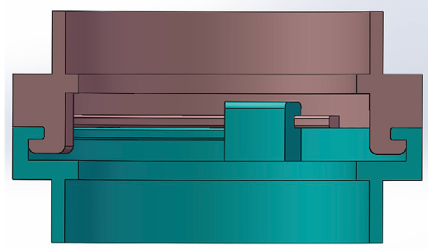
Figure 5: Sectional view of the assembly hose joint.